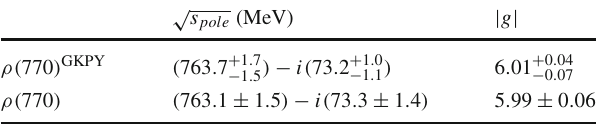
Table 12 Pole position and ππ coupling of the ρ( 770 ) , which are almost indistinguishable for solutions I, II and III. They nicely agree with the GKPY dispersive result in [36] that we also provide for com-